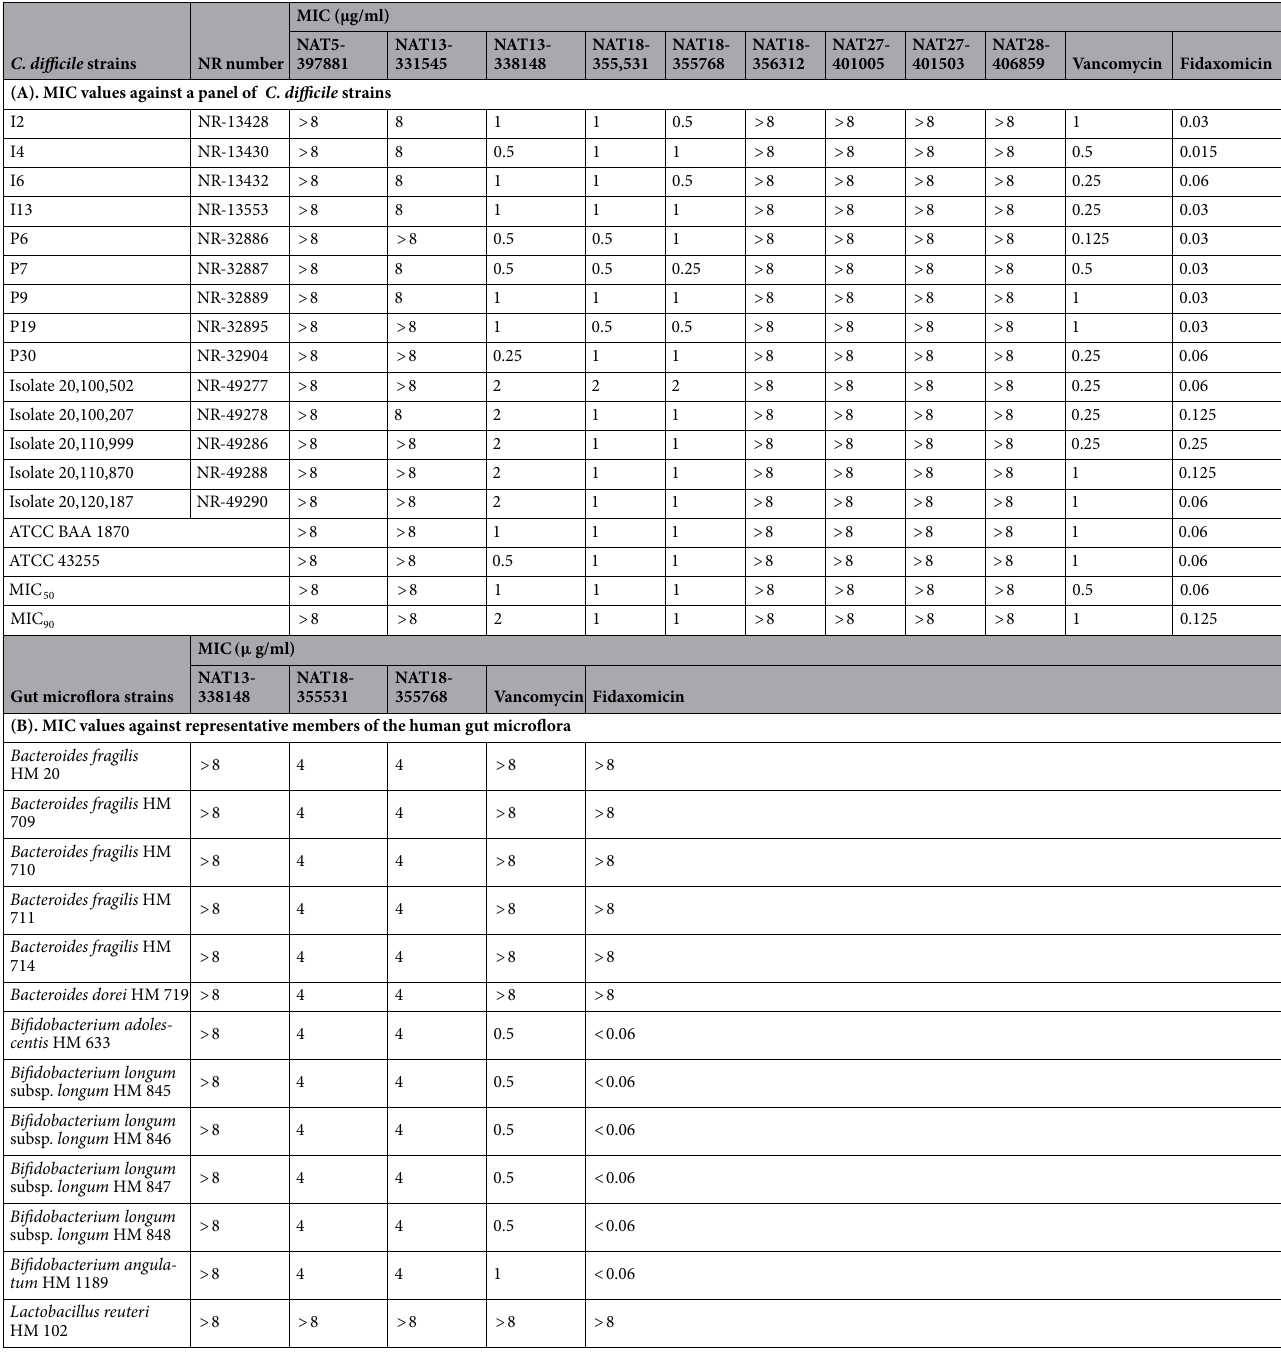
Table 1. Determination of minimum inhibitory concentration (MIC) values of hit compounds along with controls vancomycin and